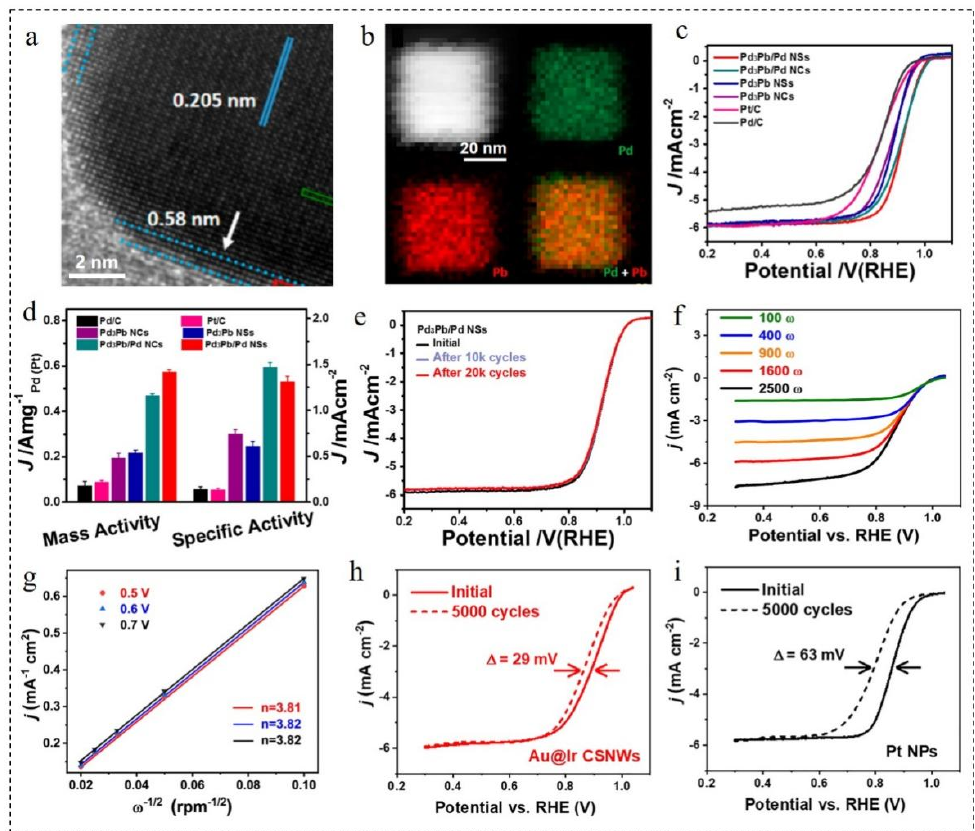
Figure 3. ( a ) HRTEM image, ( b ) HAADF-STEM image and corresponding elemental mappings